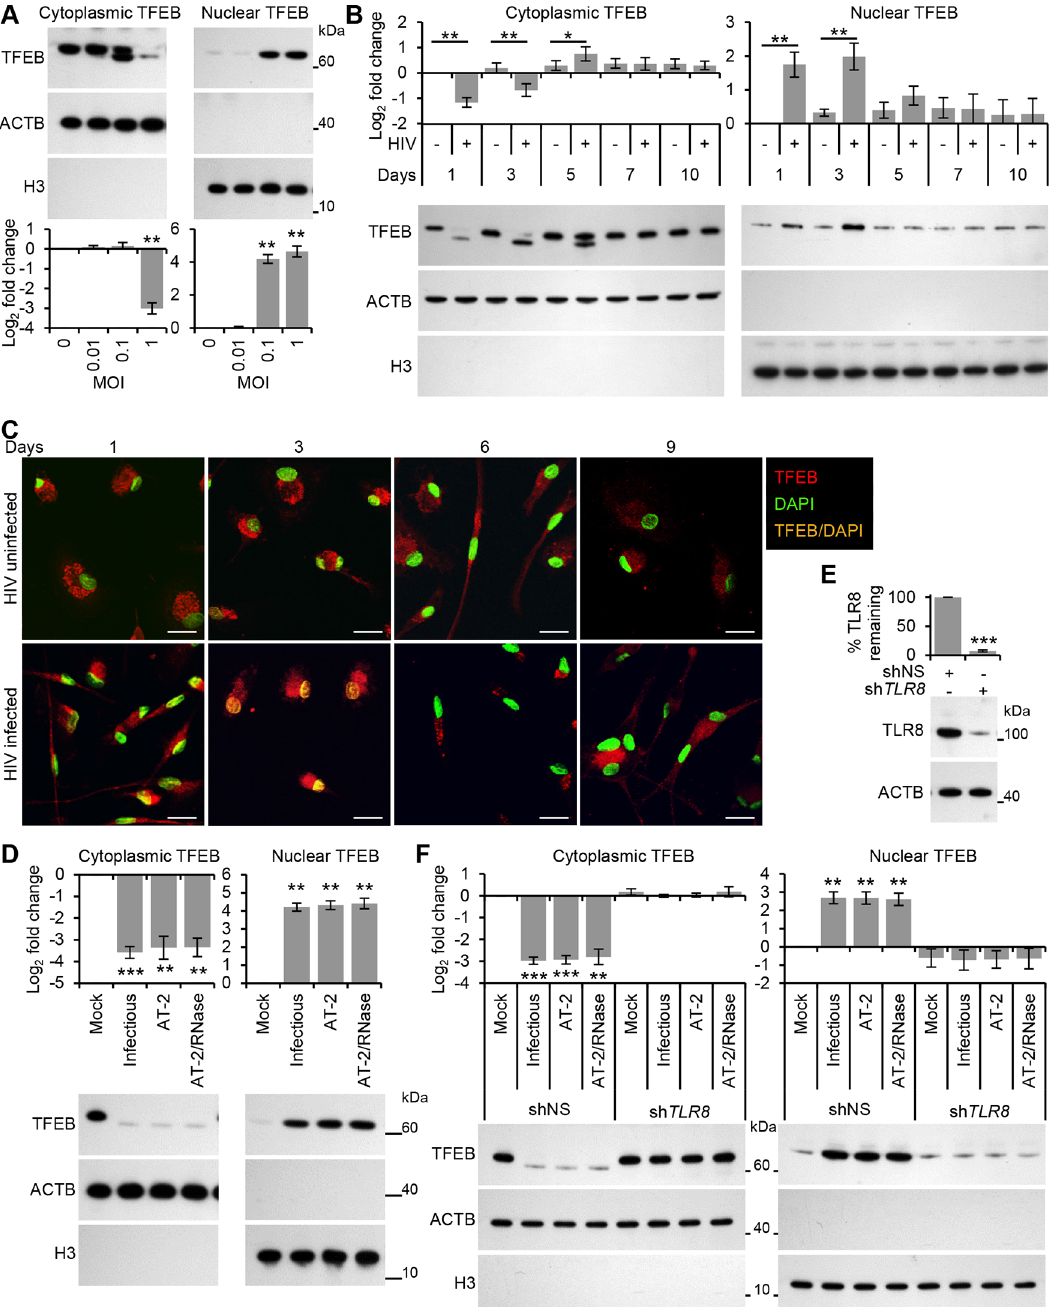
Fig 4. HIV induces TFEB nuclear localization in human macrophages through TLR8. (A) Macrophages were exposed to increasing concentrations of purified HIV for 24 h, harvested, lysed, fractionated for cytoplasmic and nuclear content, and analyzed for TFEB, ACTB and H3 histone by Western blotting. Top , a representative blot is shown. Bottom , densitometric analysis of immunoblots from independent donors presented as means ± s.e.m., n = 3. (B) Macrophages were infected with HIV and at 1, 3, 5, 7, and 10 days post-infection cells were harvested, lysed and fractionated for cytoplasmic and nuclear content, and analyzed for TFEB, ACTB and H3 histone by Western blotting. Bottom , a representative blot is shown. Top , densitometric analysis of immunoblots from independent donors presented as means ± s.e.m., n = 6. (C) Representative fluorescence microscopy images of HIV-infected macrophages which were fixed, permeabilized then stained with 4',6-diamidino-2-phenylindole (DAPI; green ) and antibody to TFEB ( red ) at the indicated times post-infection. Co-localization of TFEB and DAPI staining is represented in the image by orange pixels. Scale bars indicate 20 μ m. (D) Macrophages were exposed to mock, infectious, AT-2-inactivated, or RNase/DNase I treated AT-2-inactivated iodixanol velocity gradient purified HIV Ba-L for 24 h, harvested, lysed fractionated for cytoplasmic and nuclear content, and analyzed for TFEB, ACTB and H3 histone by Western blotting. Bottom , a representative blot is shown. Top , densitometric analysis of immunoblots from independent donors presented as means ± s.e.m., n = 3. (E) Macrophages